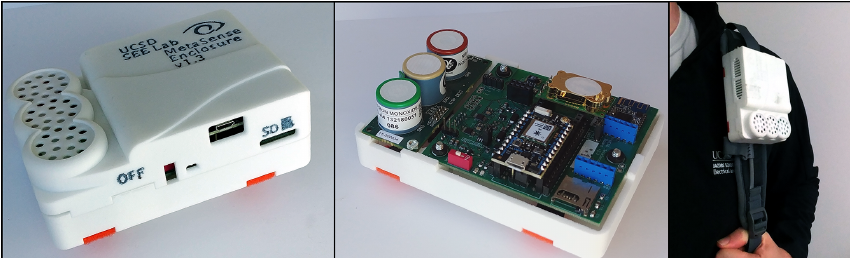
Figure 2. An enclosure was 3-D printed for the MetaSense Air Quality Sensing Platform with top-side ports above the electrochemical sensors and a side port next to the ambient environmental sensors. The sensor is sized to be portable and has velcro straps that can be used to mount it to backpacks, bicycles,